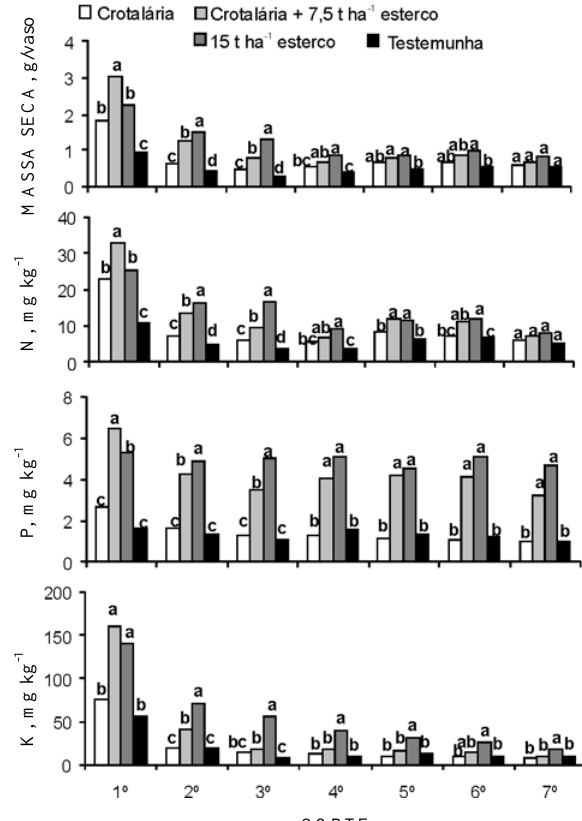
Figura 3. Produção de matéria seca e acúmulo de N, P e K em sete cortes sucessivos da parte aérea do capim-buffel cultivado por 300 dias em vasos com 700 g de solo (Neossolo Regolítico), após aplicação de esterco e, ou,